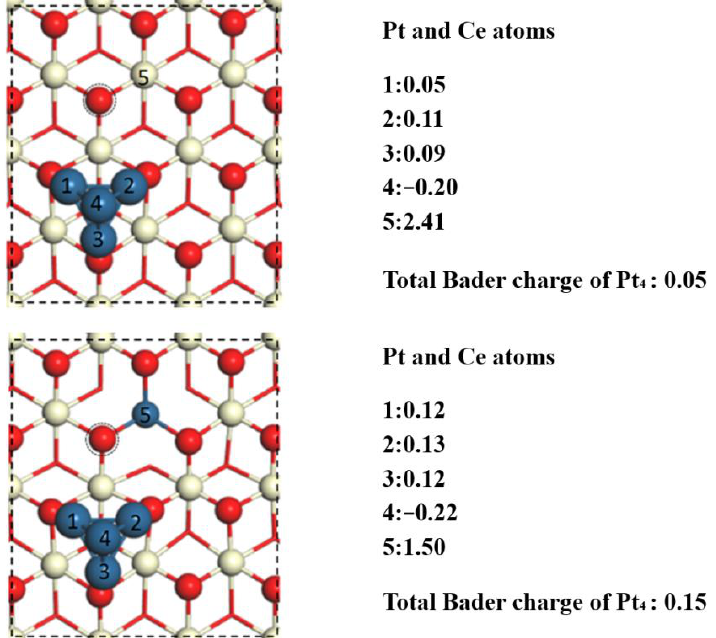
Figure 4. Bader charge analysis of ( a ) Pt 4 /CeO 2 and ( b ) Pt 4 /(Pt − Ce)O 2 . The dotted circle represents the removed O atom to form oxygen vacancy.